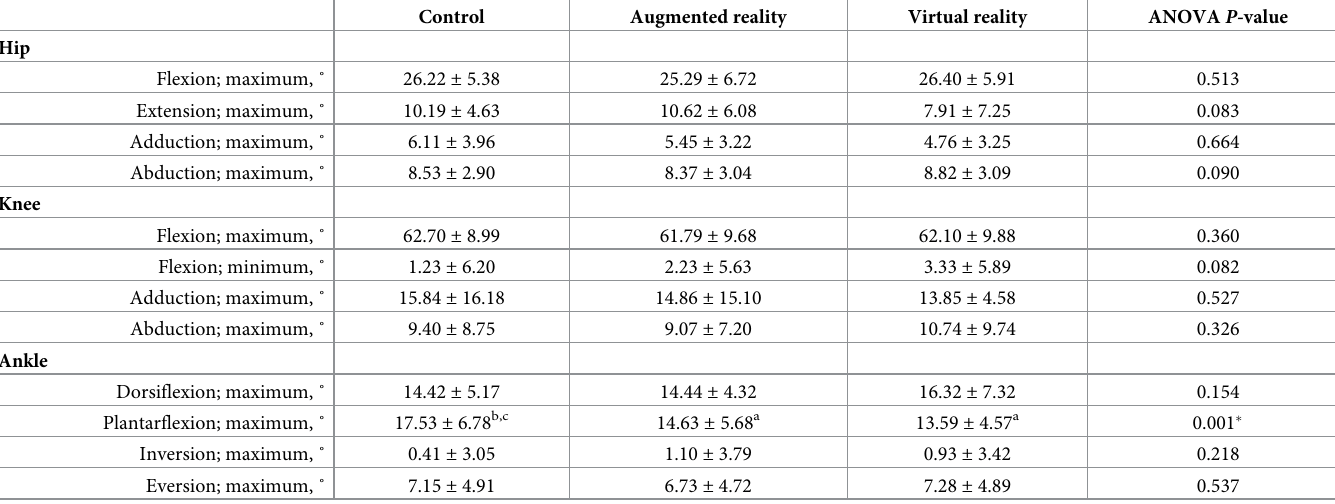
Table 2. The maximum and minimum lower-limb joint angles measured during different walking